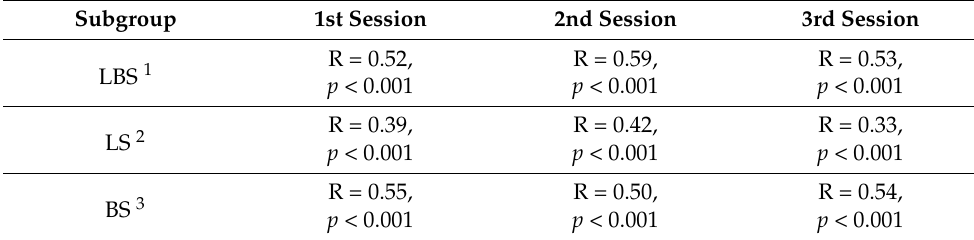
Table 10. Spearman’s rank correlation coefficient between TGMD-3 scores and grades. Subgroup 1st